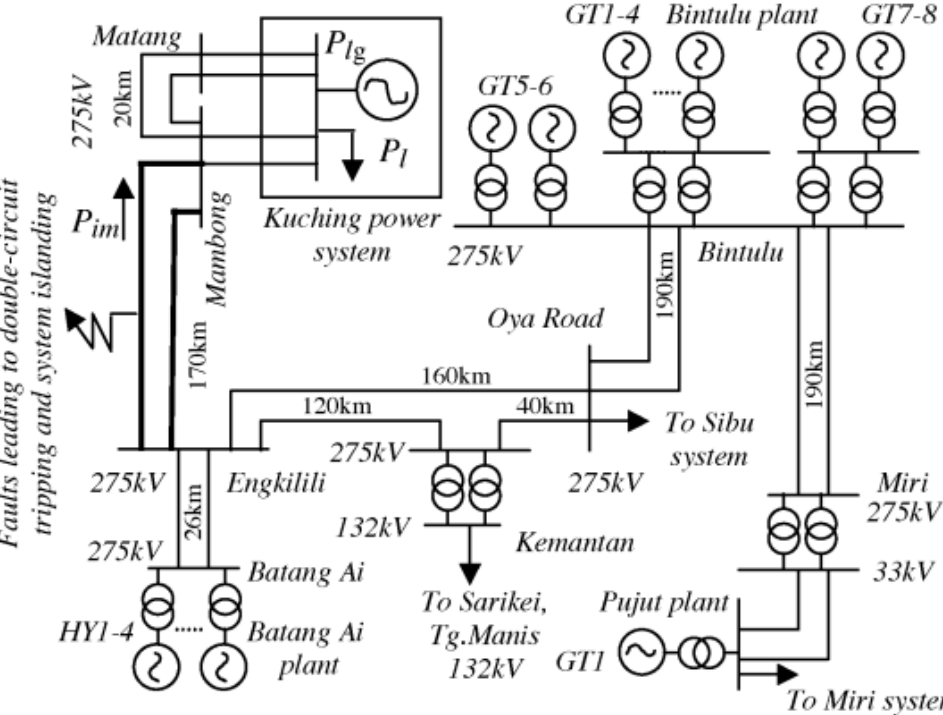
Figure 4. One-line diagram of SESCO grid transmission system.